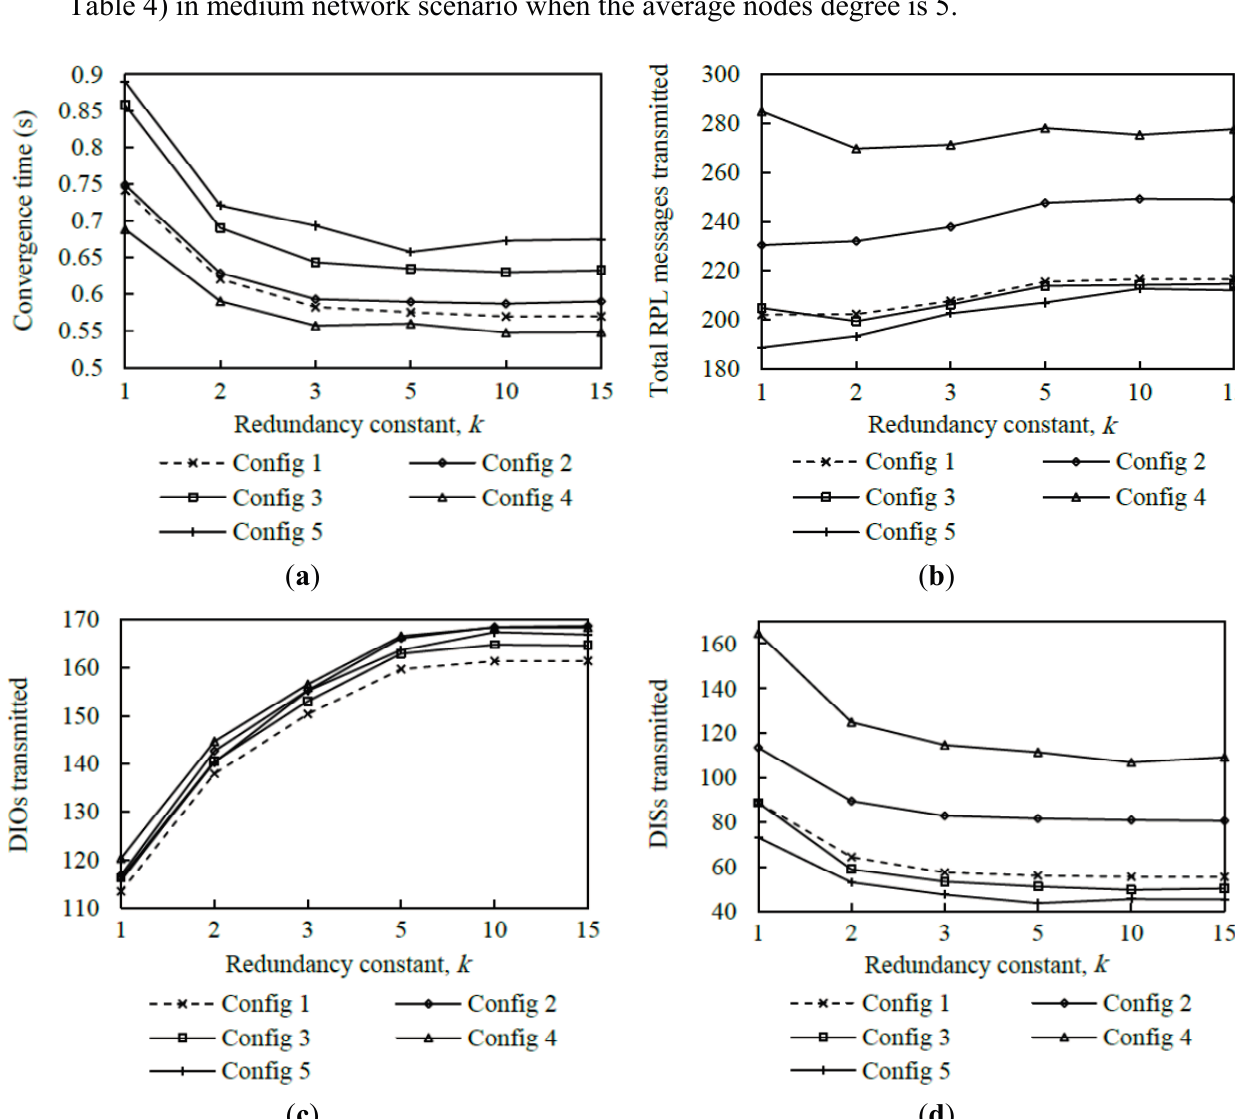
Figure 21. Comparing performance of different DIS-Trickle parameters settings (shown in Table 4) in medium network scenario when the average nodes degree is